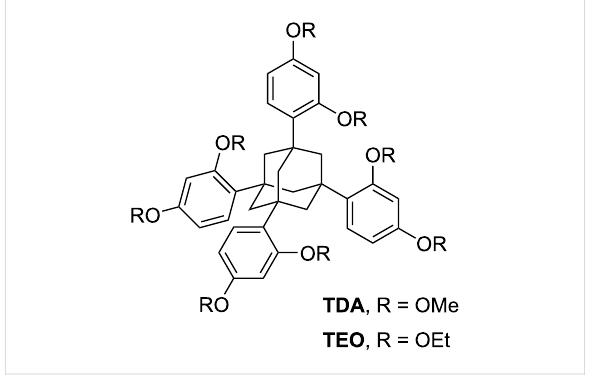
Figure 1: Structure of TDA and TEO, the crystallization hosts used for